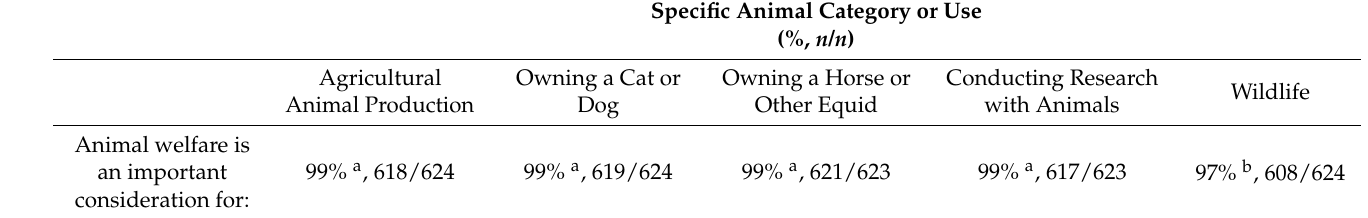
Table 1. The percentage of respondents that selected “strongly agree” or “agree” in response to the question “animal welfare is an important consideration” for each of the following: agricultural animal production, owning a cat or dog, owning a horse or other equid, conducting research with animals, and for